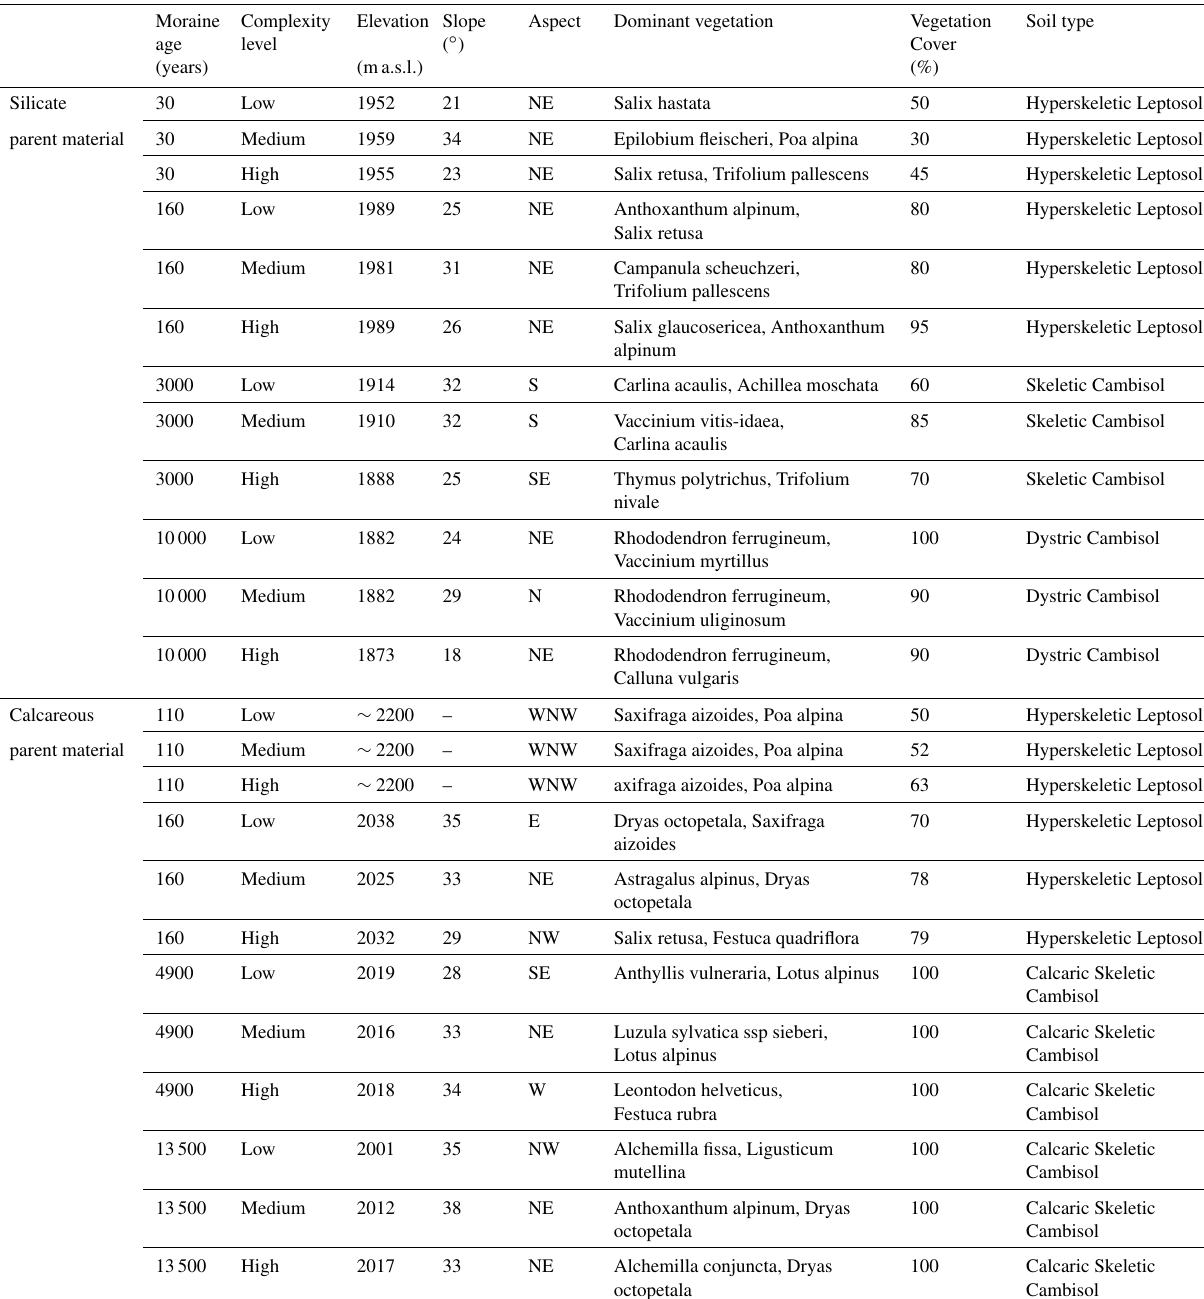
Soil type Cover (%)